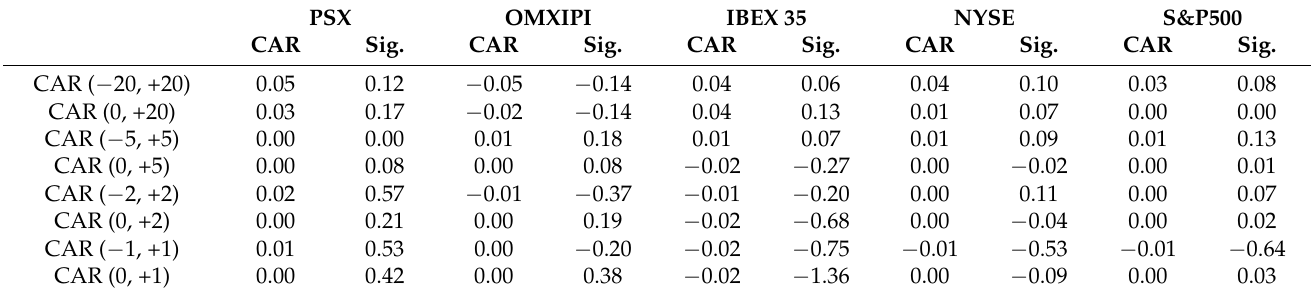
Table A19. Cumulative abnormal returns (Prime Minister of Iceland announced his resignation).